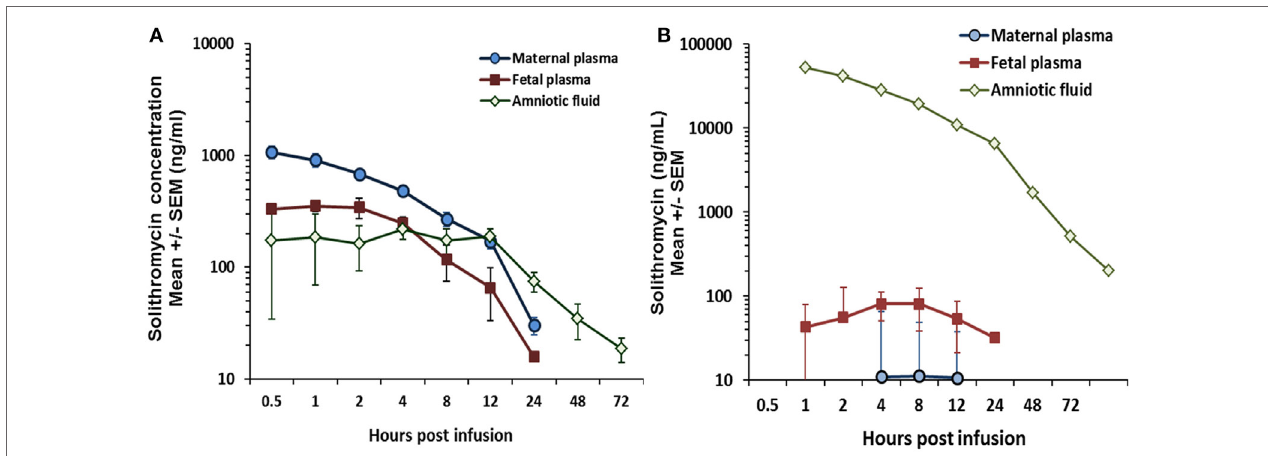
FiGURe 3 | (A) Biodistribution of solithromycin in pregnant sheep, showing concentrations in the maternal, fetal, and amniotic fluid (AF) compartments after maternal intravenous administration (10 mg/kg); (B) Plasma and AF concentration data in the same model after intra-amniotic injection (1.4 mg/kg fetal weight); azithromycin and solithromycin data taken from Ref